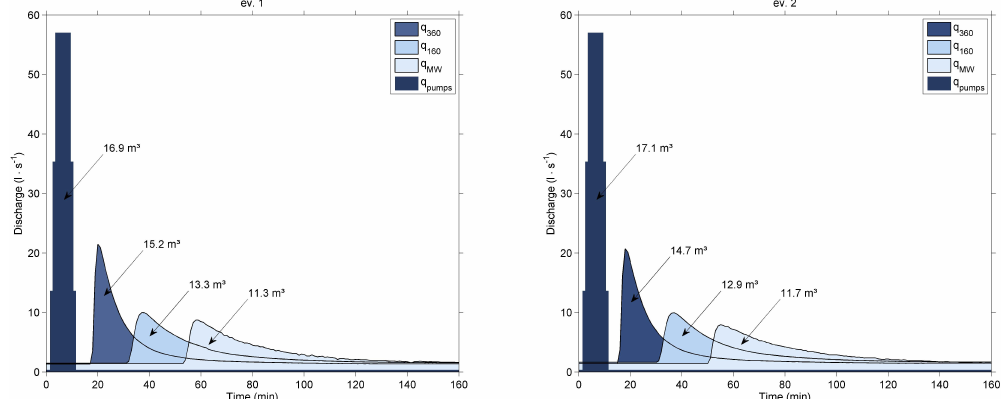
Fig. 6. Hydrographs of the first (ev.1) and second (ev.2) flooding experiment at the flood initiation location and three monitoring sites (see Fig. 2).